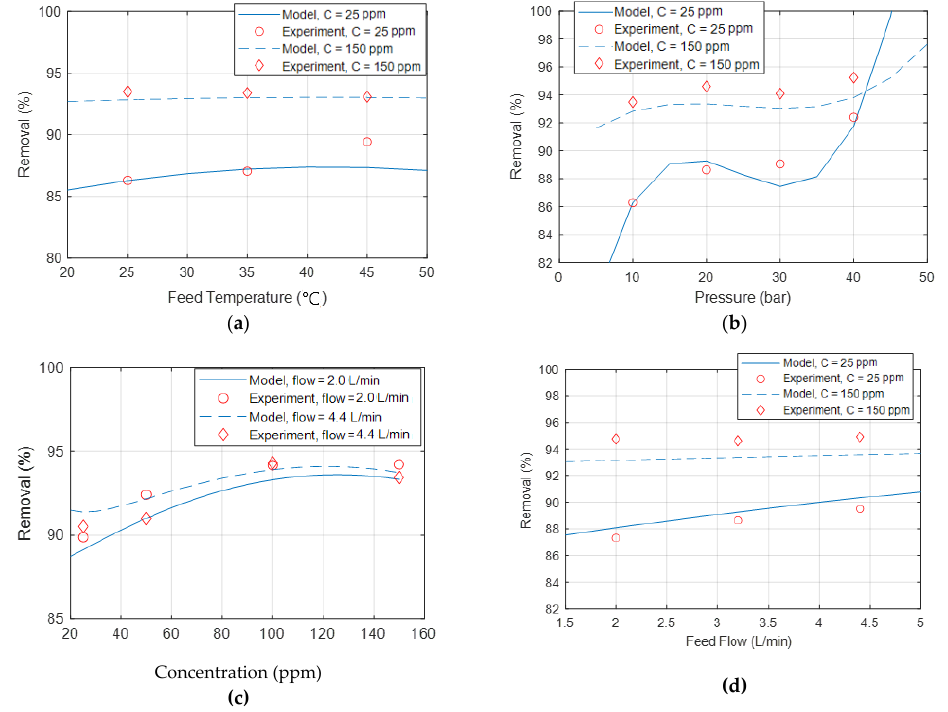
Figure 8. Comparison between nickel rejection percentages obtained experimentally vs. model- generated data under different ( a ) temperatures, ( b ) pressures, ( c ) concentrations, and ( d ) flow rates.